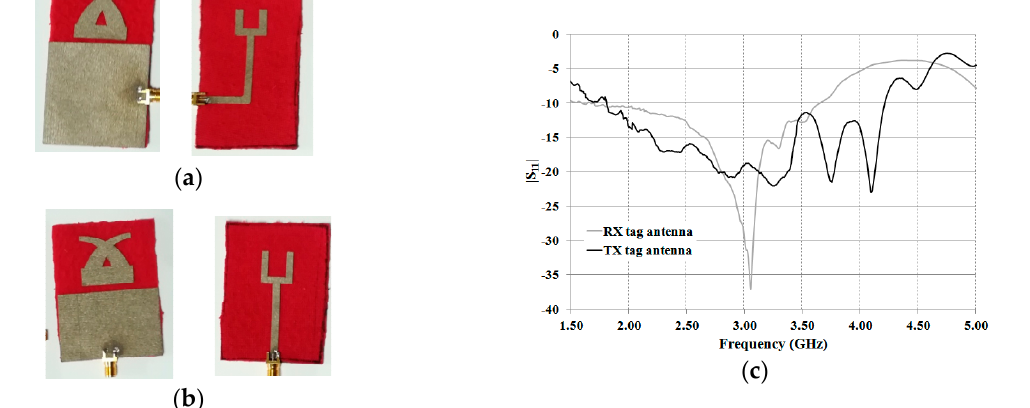
Figure 9. Experimental results achieved for the TX tag antenna and the RX tag antenna: ( a ) front view and back view of the RX antenna prototype; ( b ) front view and back view of the TX antenna prototype; ( c ) measured reflection coefficients.